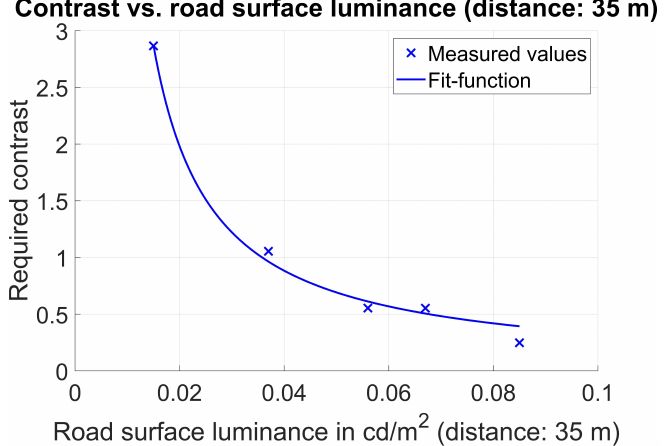
Figure 1. Influence of the roadway luminance on the Weber contrast required for object detection. Ac- cording to Damasky [21], the necessary Weber contrast decreases with increasing roadway luminance. This behavior can be described by a rational fit